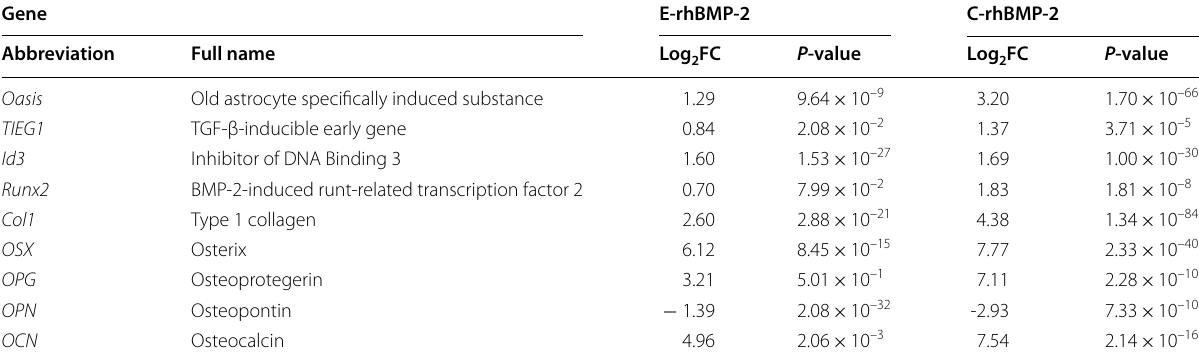
Table 4 Expression levels of osteogenic marker genes at 24 h after rhBMP‑2 treatment